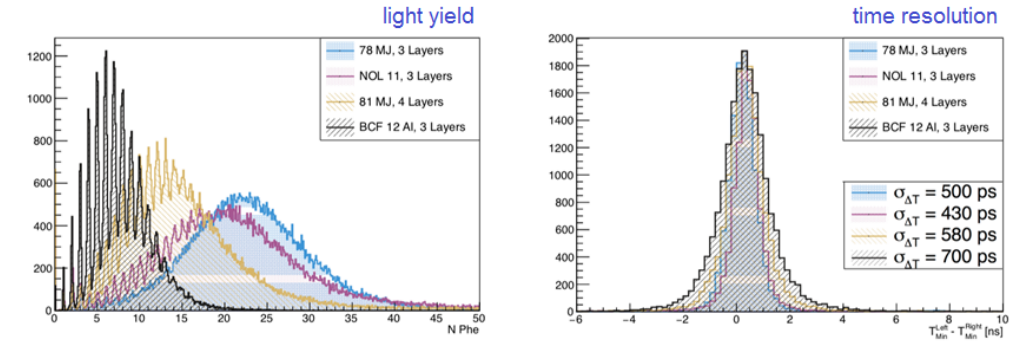
Figure 9: Characterization of different scintillating fibers: light yield (left) and mea- sured time resolution